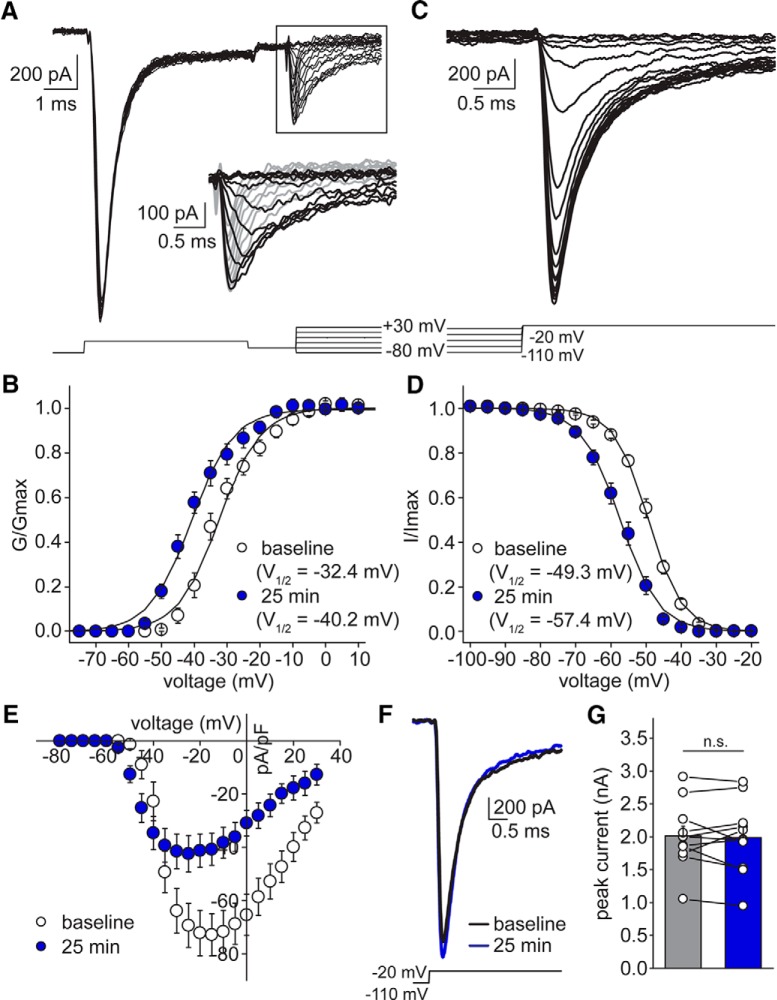
Na+ current SCs exhibits shift in both activation and inactivation properties, but not current density. A, Example voltage-clamp traces of Na+ currents evoked with a prepulse protocol (patch #170222p4). Inset, Zoom-in of portion of traces depicting strong voltage-clamp of Na+ currents evoked after prepulse. B, Summary plot of voltage dependence of activation of Na+ current at baseline (white circles) and at 25 min (blue circles; n = 11 cells). C, Example traces from a Na+ inactivation protocol (patch #170222p4). D, Summary plot of voltage dependence of inactivation at baseline (white circles) and at 25 min (blue circles; n = 11 cells). E, Summary current density-voltage plot (data used to construct conductance-voltage plots in B, D, of sodium responses at baseline (white circles) and at 25 min (blue circles). F, Example peak sodium current traces evoked by a –110 to –20 mV probe at baseline (black) and at 25 min (blue; patch #171108p3). G, Summary graph of peak sodium currents evoked from a holding potential of –110 mV at baseline (gray) and at 25 min (blue). n.s. denotes p > 0.05.